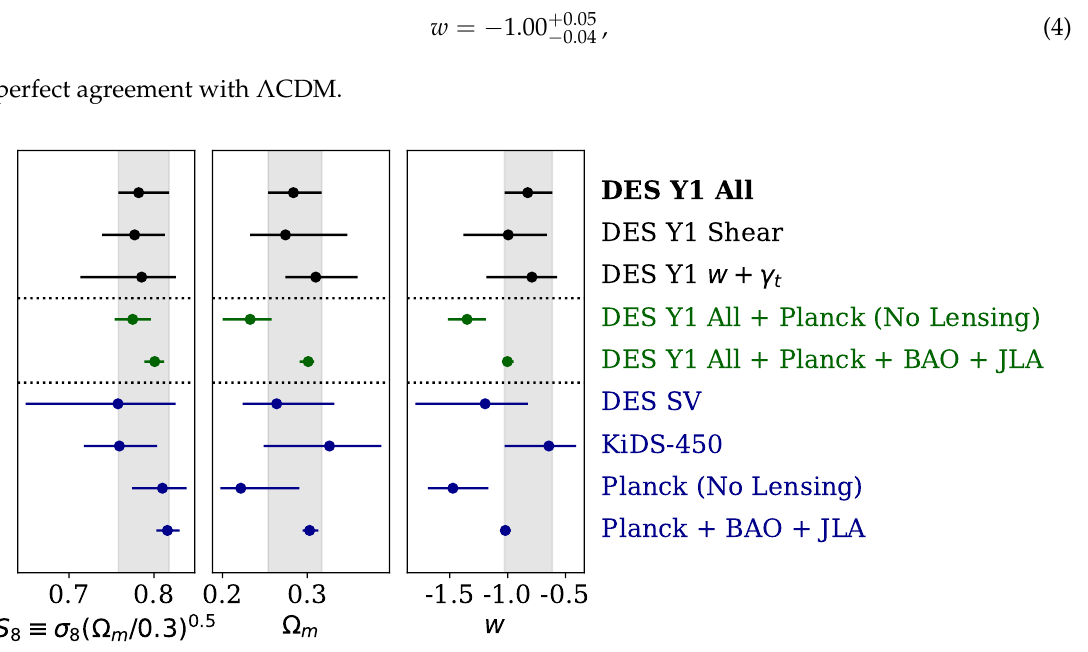
Figure 6. Results for S 8 and Ω m within w CDM obtained from DES and other experiments, similar to Figure 4. From Abbott et al.